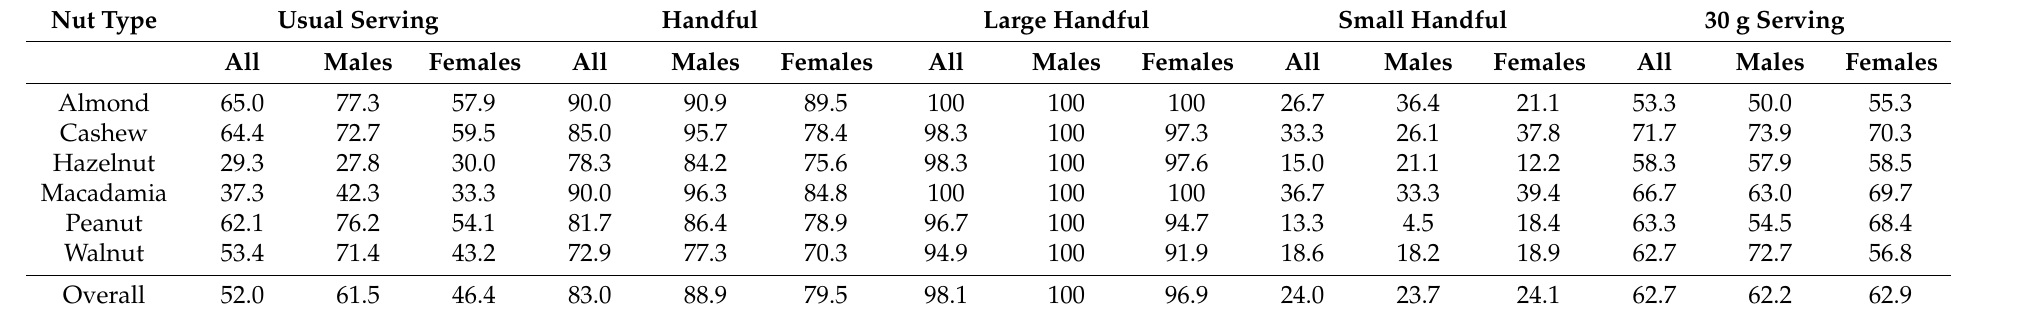
Table 3. Percentage of participants selecting at least 80% of the recommended intake (30 g) for the different portion measures.